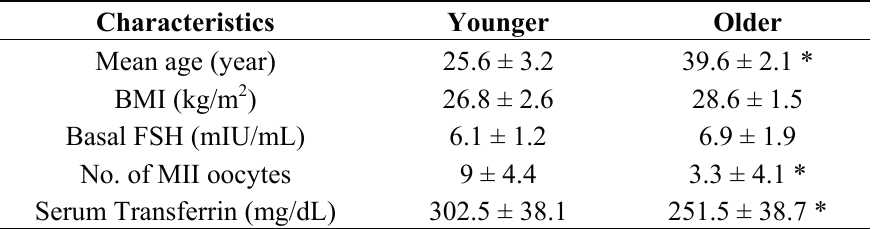
Table 1. Clinical characteristics of